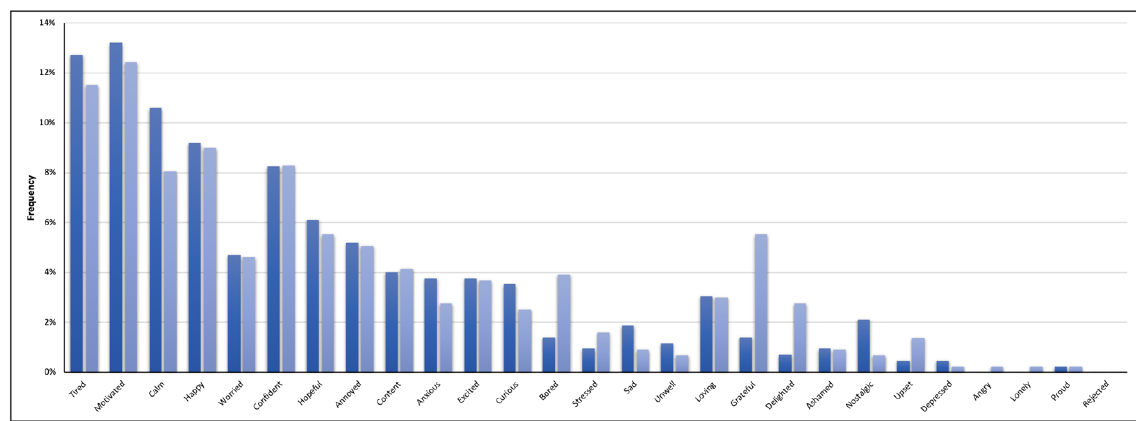
Figure 2. Frequency of initial moods in music episodes (dark blue bars) and non-music episodes (light blue bars).